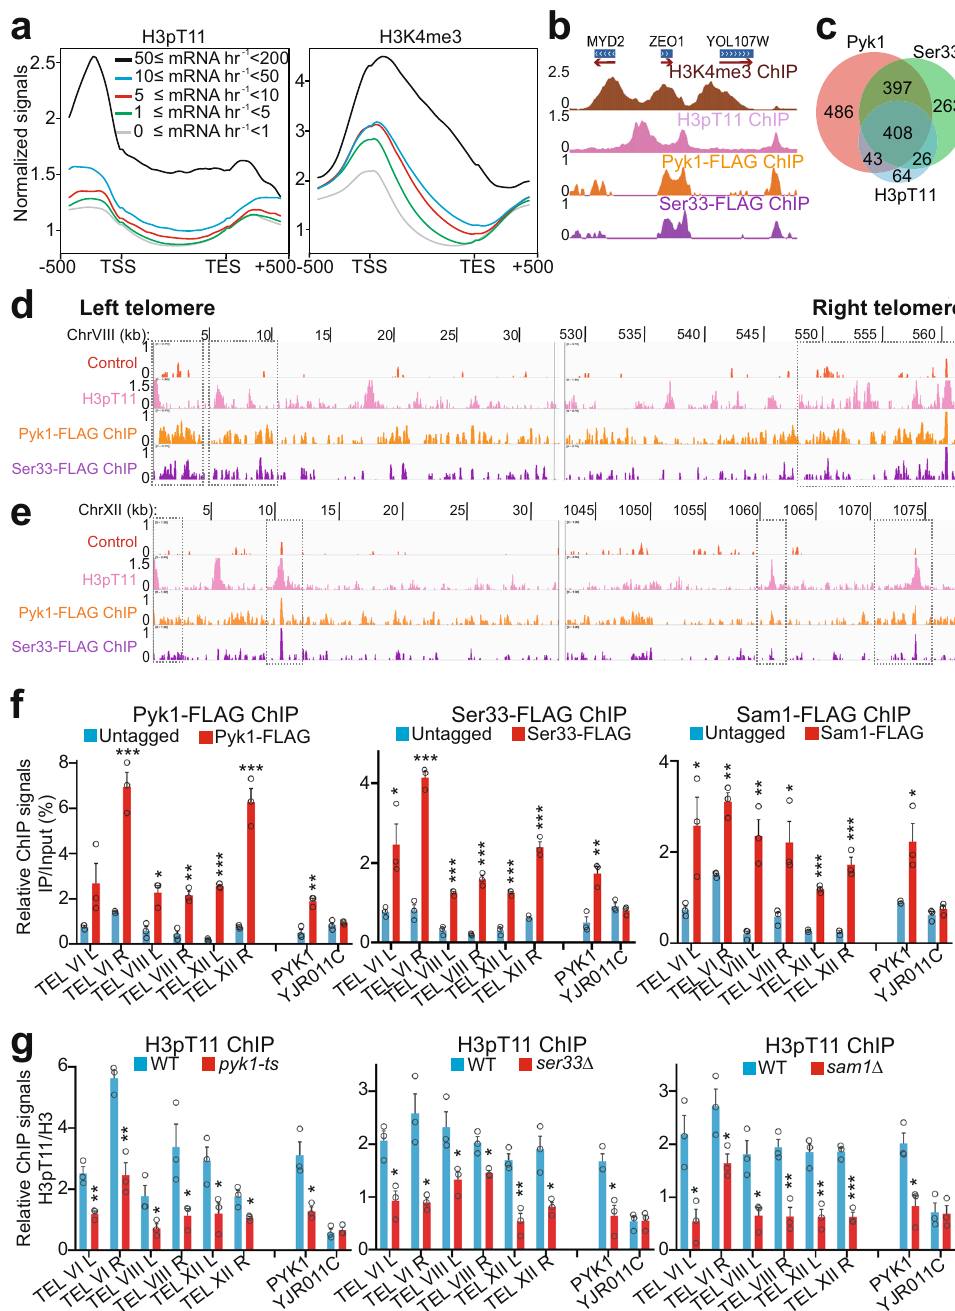
Fig. 1 SESAME phosphorylates H3T11 at gene promoters and telomere regions. a The composite binding pro fi le of H3pT11 at 5065 genes which were divided into fi ve groups according to their transcription rates. The log 2 ratio of normalized enrichment (H3pT11/H3, H3K4me3/H3) for each gene region, including 500 bp upstream and downstream regions from the gene, were used for average gene analysis. The transcription start site (TSS) and termination site (TES) are indicated. b ChIP-seq tracks showing the occupancy of H3K4me3/H3, H3pT11/H3, Pyk1, and Ser33 at representative genes. c Venn diagram of genes that overlap among the Pyk1-peak, Ser33-peak, and H3pT11-peak gene sets as determined by ChIP-seq. The numbers of binding sites are represented. d , e ChIP-seq tracks showing the occupancy of H3pT11/H3, Pyk1, and Ser33 at the left and right telomere regions of chromosome VIII (TEL VIII) ( d ) and chromosome XII (TEL XII) ( e ). The control tracks were generated using untagged BY4741 strain with anti-FLAG antibody. f ChIP-qPCR analysis of Pyk1, Ser33, and Sam1 at telomeres of chromosome VI (TEL VIL and TEL VIR), chromosome VIII (TEL VIIIL and TEL VIIIR), and chromosome XII (TEL XIIL and TEL XIIR). The YJR011C was used as a non-target region. g ChIP-qPCR analysis of H3pT11 at telomeres in WT, pyk1-ts , ser33 Δ , and sam1 Δ mutants. Pyk1 was inactivated by growing pyk1-ts mutant at non-permissive temperature (37 °C) for 2 h. H3pT11 was normalized to histone H3 level. For Fig. 1f, g, the quantitative data represent the mean ± SE; n = 3 biological independent experiments. Statistical signi fi cance was tested using two-sided Student ’ s t test. * p < 0.05; ** p < 0.01; *** p < 0.001.